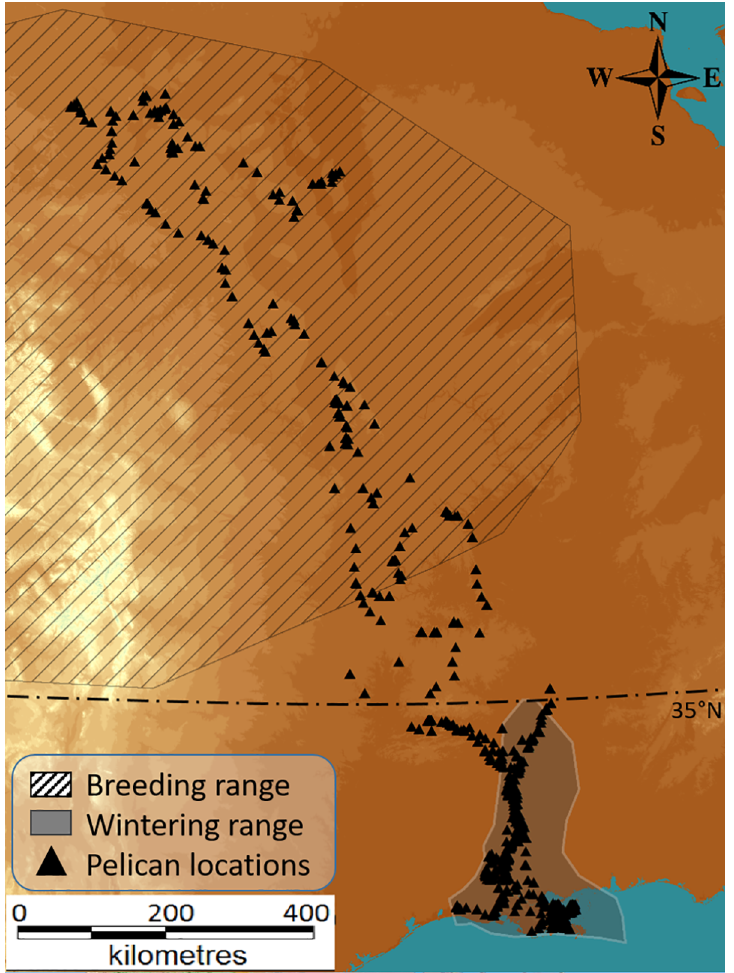
Fig 1. Map showing the geographical context of the study system, the breeding and wintering ranges of the target species and the migration routes for anexemplar individual of American white pelicans (AWPE). Elevationis shownin 100 m bandsfrom < 100 m (pale grey) to > 1500m (dark brown). Radio-tracked positionsfor an exemplarindividualare shown as back triangles.